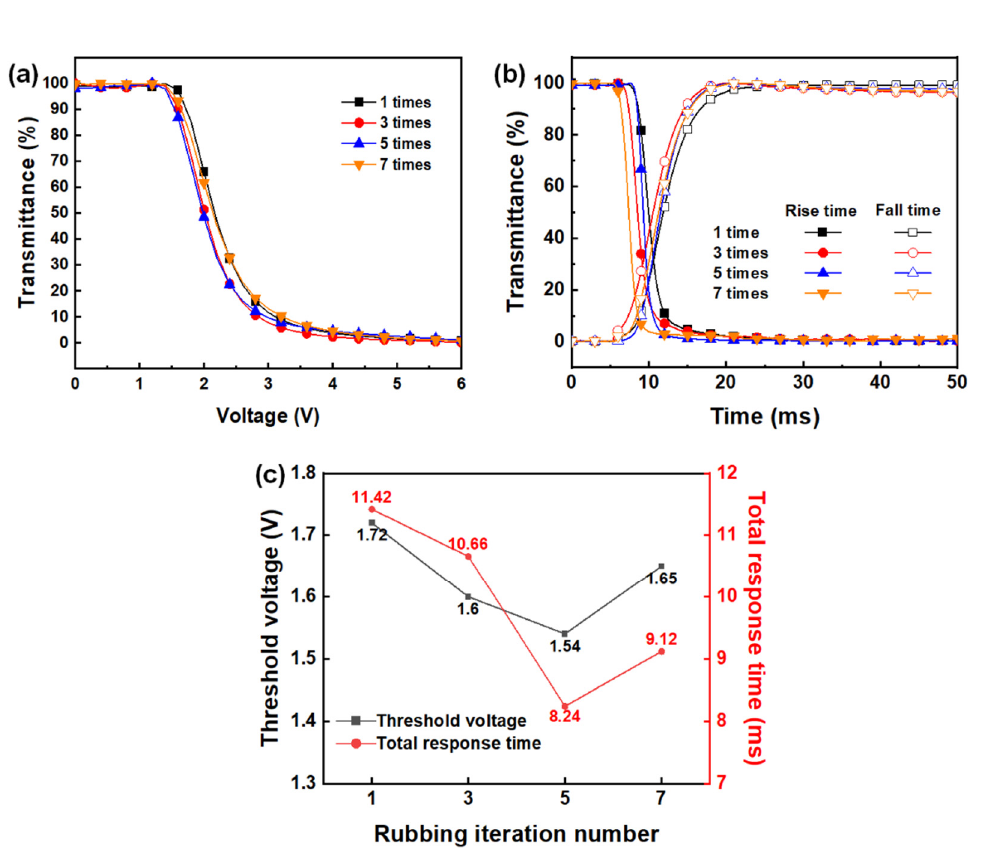
Figure 5. ( a ) Voltage–transmittance (V–T) ( b ) response time and ( c ) change trend of threshold volt- age and total response time characteristics of TN LC cells with solution-derived ZnO films as a function of rubbing iteration